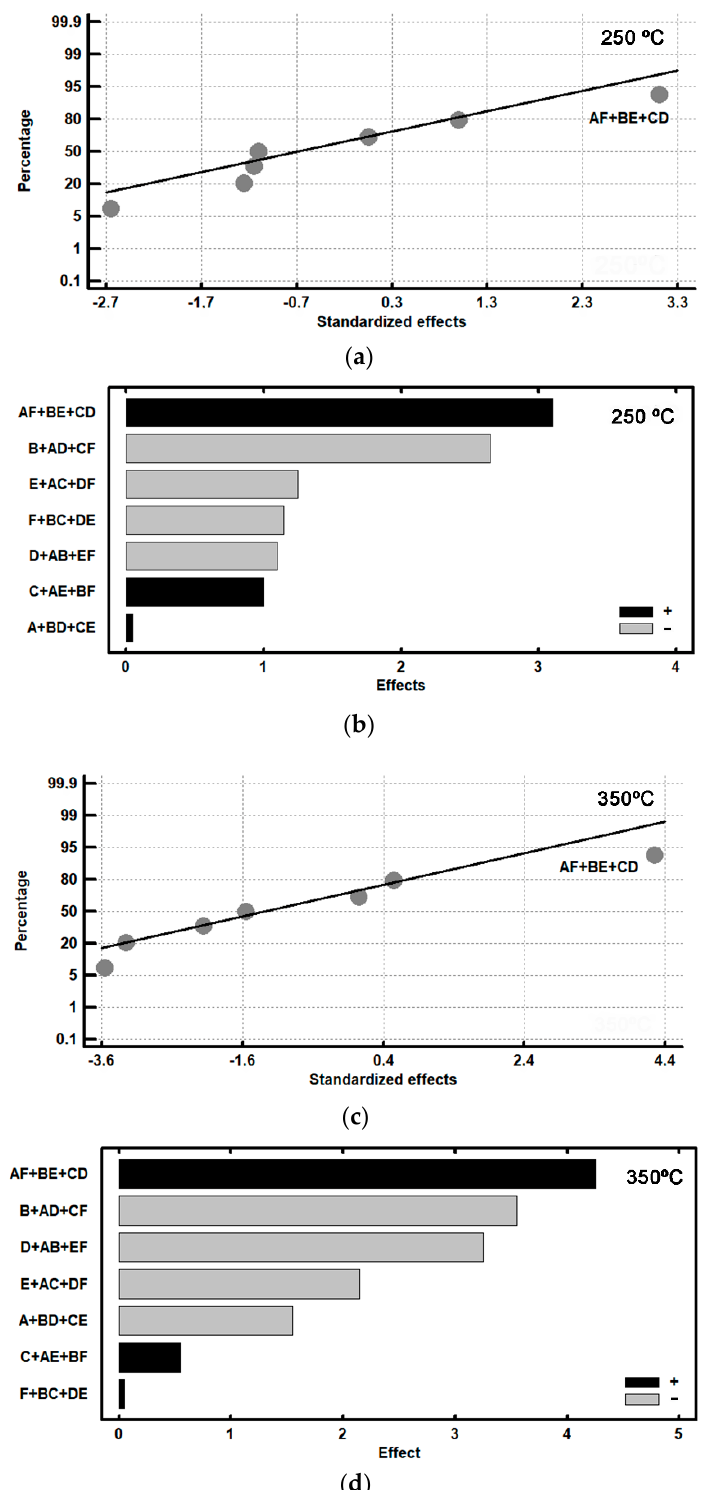
Figure 6. Graphic representation of wear in zone I (a) 250 °C. Representation of the effects on a normal probability paper; (b) 250 °C. Representation of the effects in a Pareto diagram; (c) 350 °C. Representation of the effects on a normal probability paper; (d) 350 °C. Representation of the effects in a Pareto diagram.